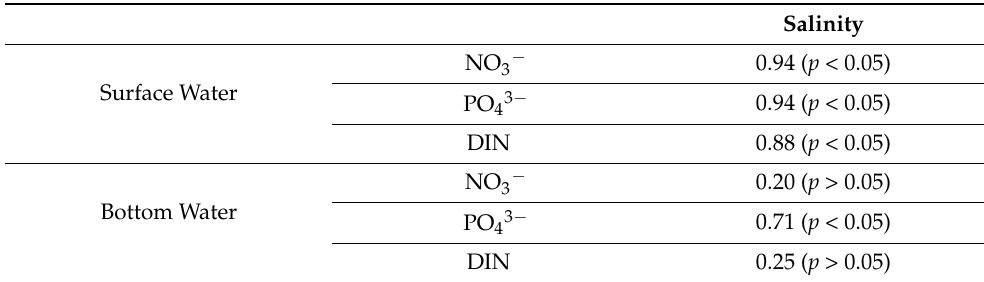
Table 2. Nutrient correlation coefficient against salinity in the surface and bottom water of Al-Arbaeen Lagoon (n = 6